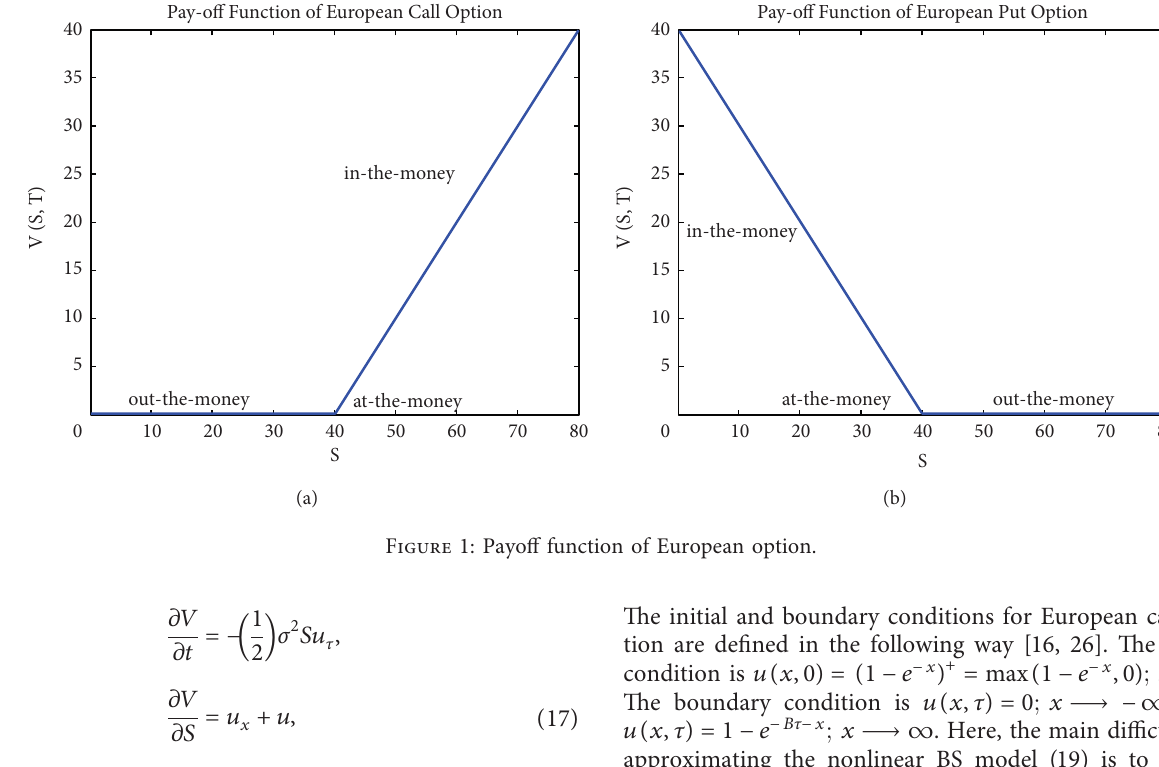
Figure 1: Payoff function of European